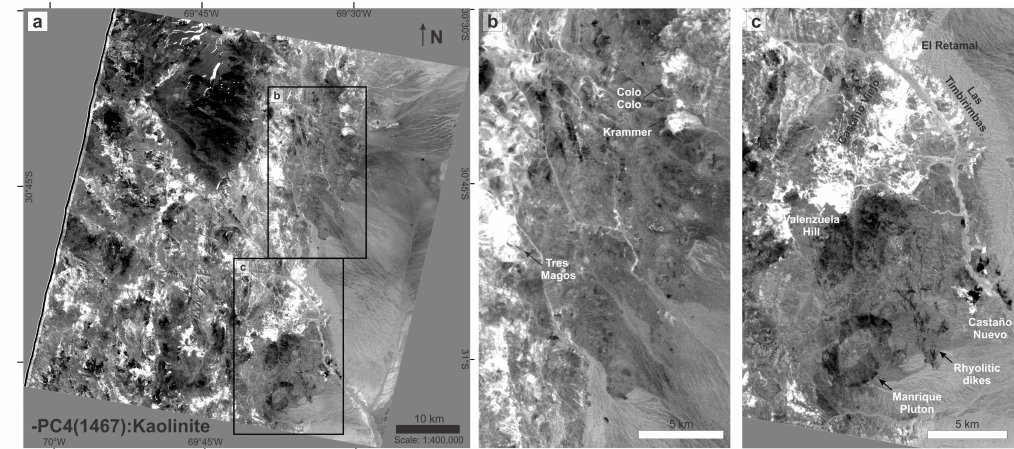
Figure 14. ( a ) Negated principal component 4 for bands 1, 4, 6 and 7 (kaolinite). The white zones represent areas where it is more likely to find kaolinite ( ± phyllosilicates). ( b ) In the northern portion of the ASTER scene the hydrothermal alteration associated to Tres Magos, Krammer and Colo-Colo are highlighted. ( c ) In the southern portion of the ASTER scene the hydrothermal alteration associated to the NNE-trending Castaño Viejo alteration zone (From Valenzuela Hill to El Retamal and Las Timbirimbas) and the more restricted Castaño Nuevo alteration zone are